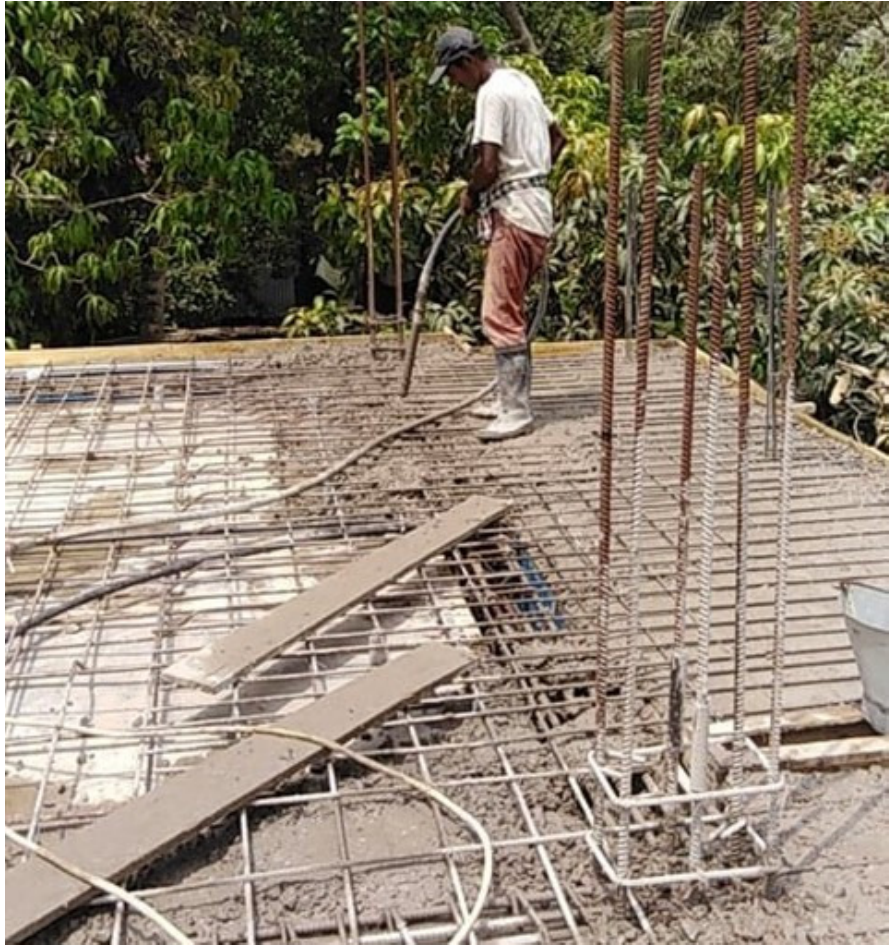
Figure 11. Use of rubber boots during concrete pouring and compaction (used with permission from Khadem [23]).